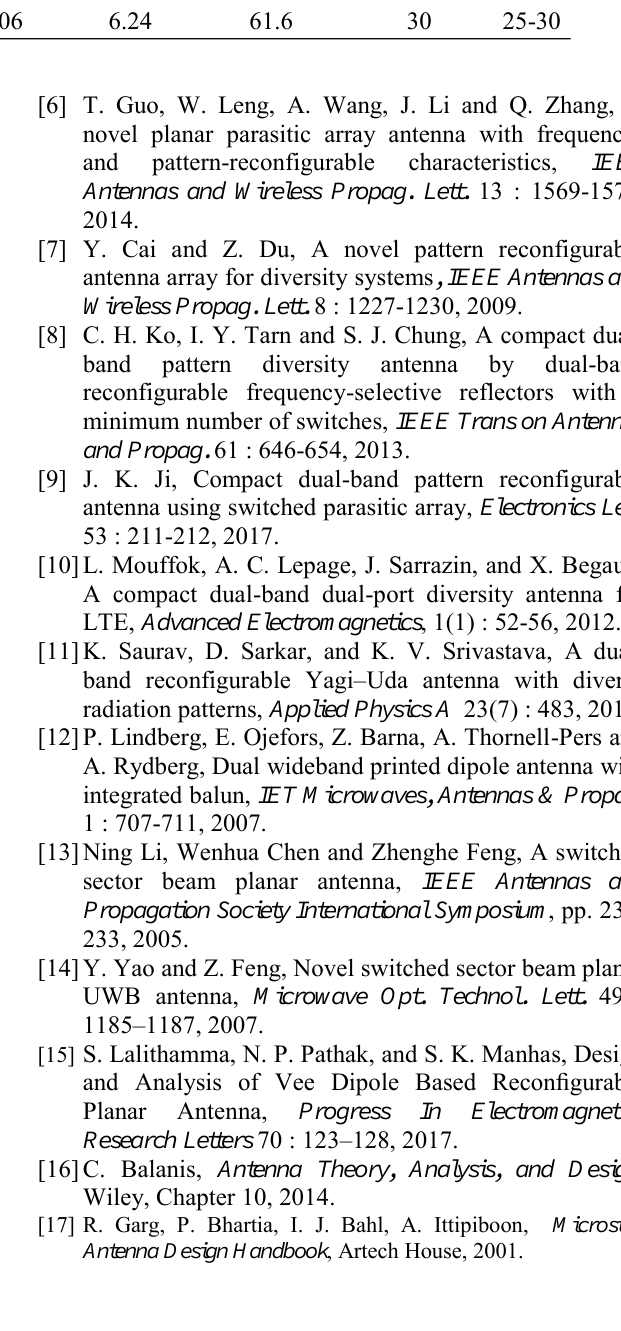
Table 2 : Antenna parameters for different configurations No. of Centre Freq (GHz) Peak gain (dBi) Simulated switches Freq Simulated Measured Simulated Measured Simulated ON